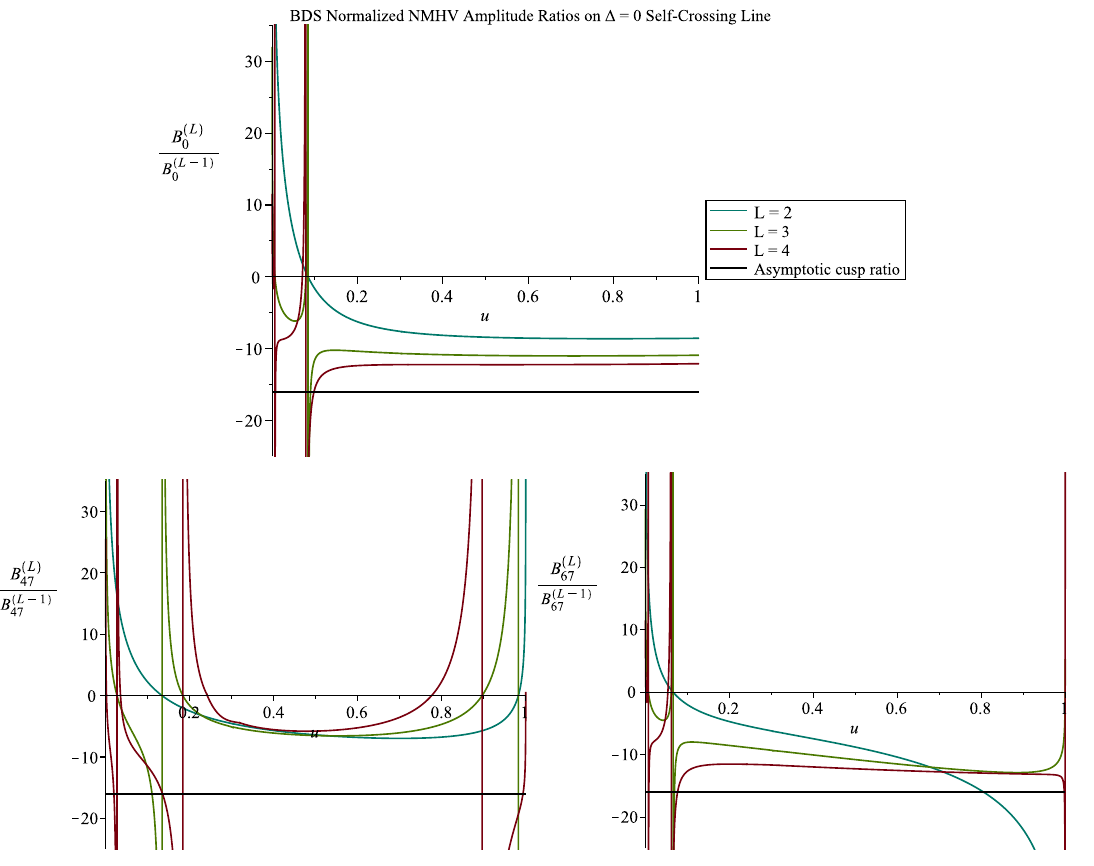
Figure 5 . Ratios of the BDS-normalized NMHV amplitude components B 0 , B 47 and B 67 at successive loop orders on Line II